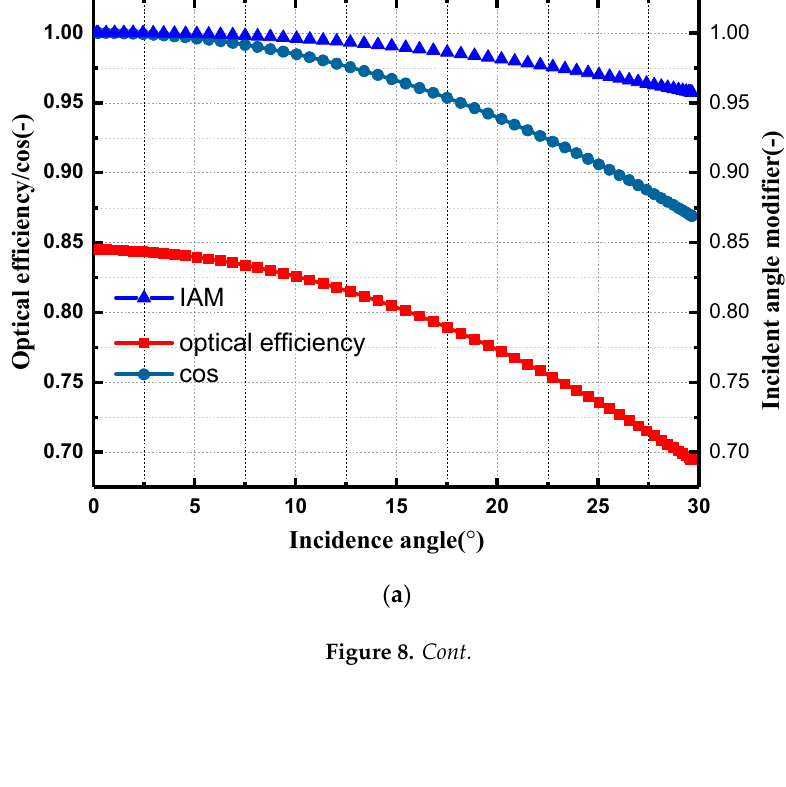
Table 3. Optimized flow split versus compressor inlet temperature (Compressor inlet pressure 7.4 MPa, outlet pressure 20 MPa and turbine inlet temperature 487 ◦ C).